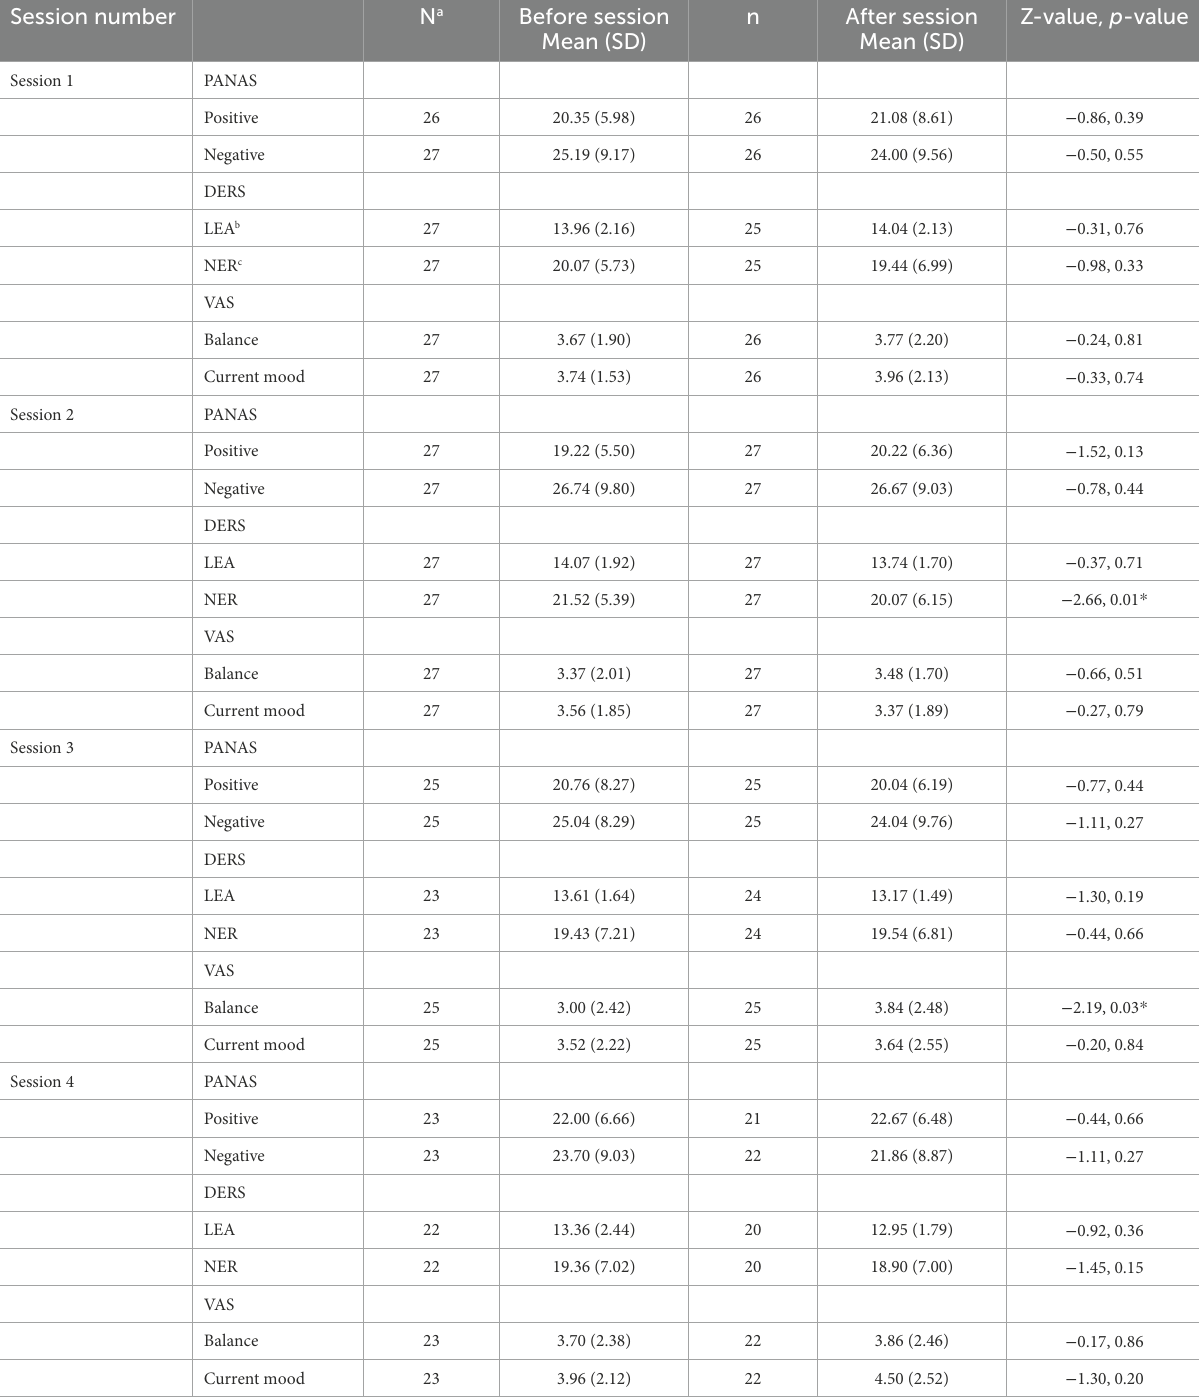
TABLE 3 Participants’ indicated state of affect (PANAS), emotional dysregulation (DERS), and state of emotion (VAS) - before and after session. Session number N a Before session